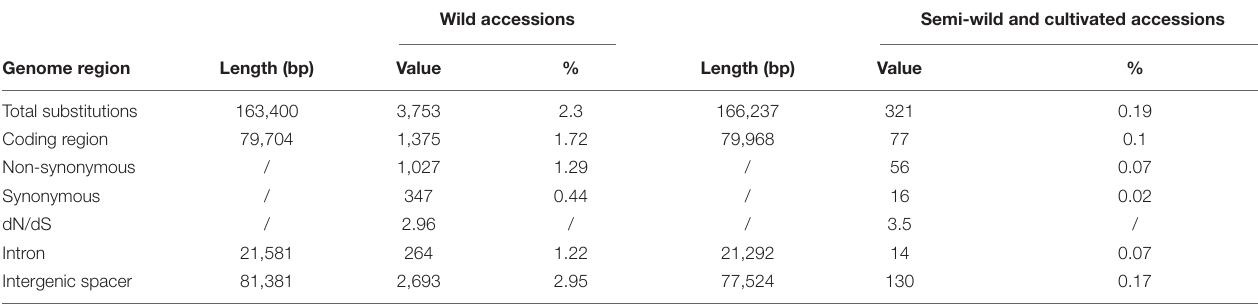
TABLE 3 | Taxonomic and genomic distribution of biallelic single nucleotide polymorphic loci in wild, semi-wild, and cultivated cotton plastid genomes.